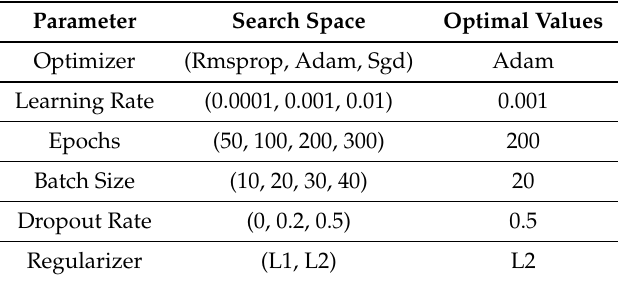
Table 2. Hyper-parameters of the CNN-LSTM.